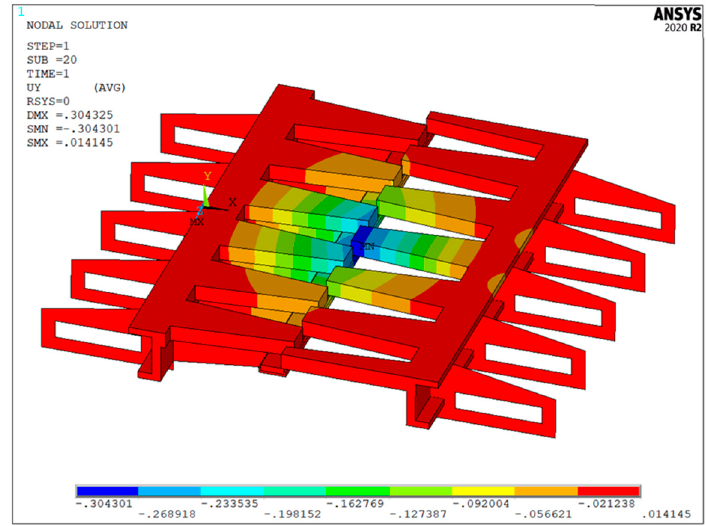
Figure 11. Vertical deformation diagram of the structure under the working condition II. Table 4. Results of deformation of the structure under working condition II..